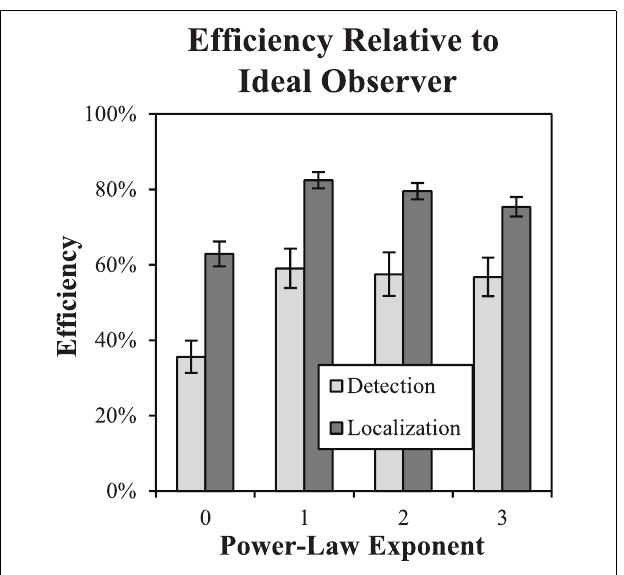
FIGURE 8 | Task efficiency. Efficiency of detection and localization tasks is plotted as a function of the power-law exponent, showing a substantial increase for localization tasks. Error bars are ± 1